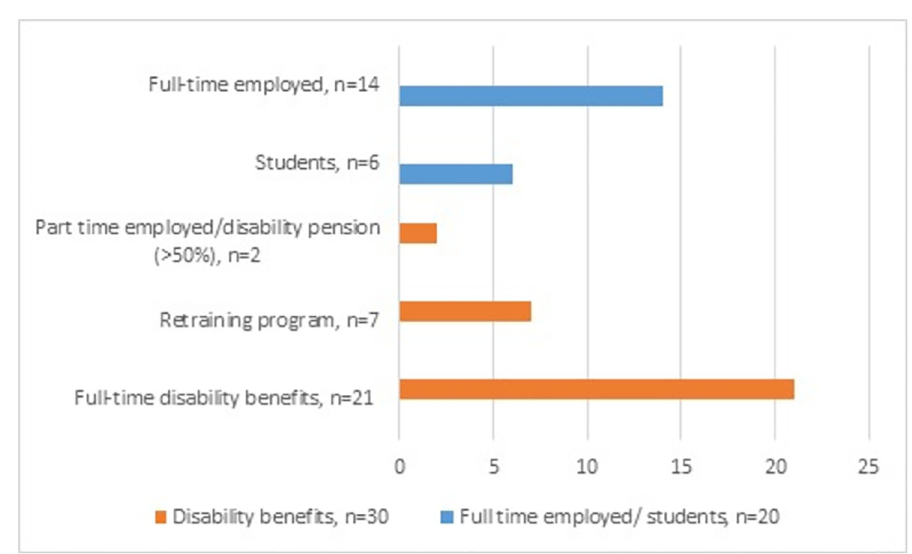
Fig 2. Distribution (%) of employment status, fulltime employment/students vs. disability benefits.